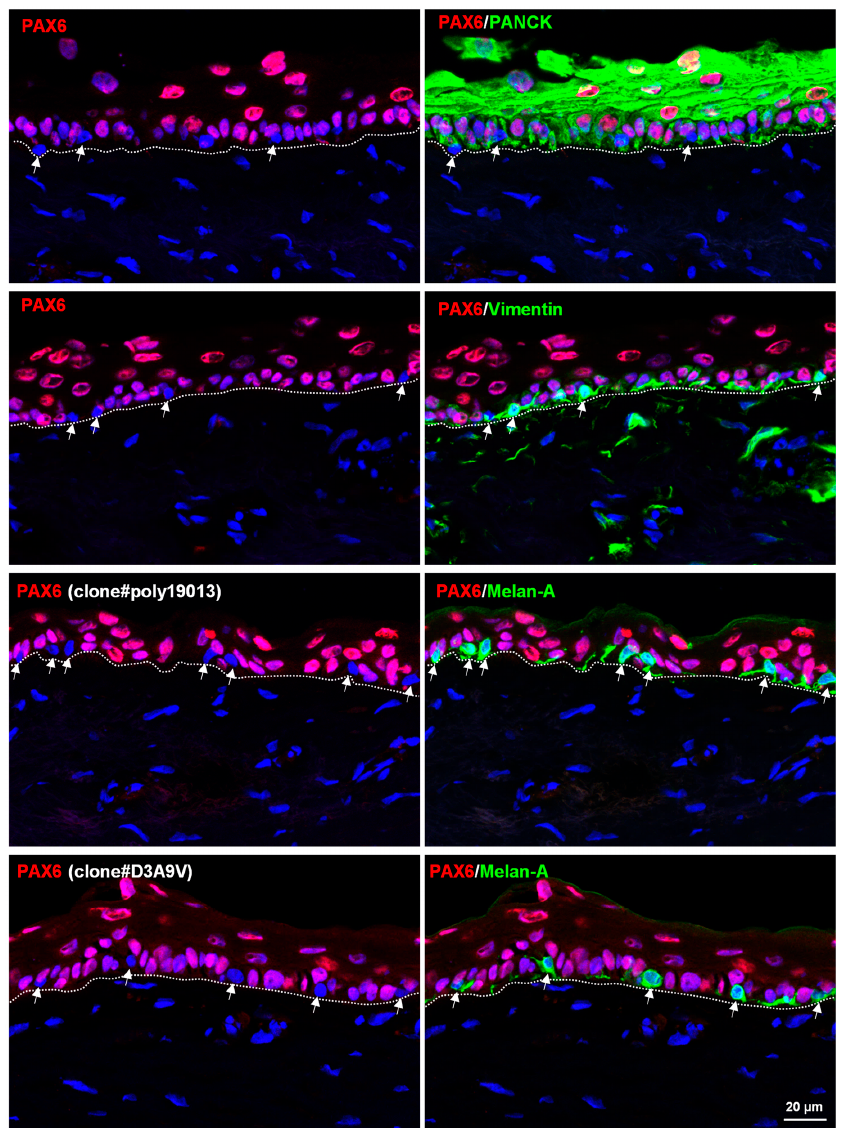
Figure 3. In situ localization of PAX6 in organ ‐ cultured human corneoscleral tissues ‐ Double immunostaining of organ ‐ cultured corneoscleral sections showing the expression of vimentin (arrow, green) but not the epithelial keratins (Pan ‐ CK, green) in PAX6 ‐ negative cells. PAX6 was not expressed by any of the cells in the limbal stroma (vimentin ‐ positive cells, green). Immunostained limbal sections also showing the expression of melanocyte marker Melan ‐ A (arrow, green) in the PAX6 ‐ negative cells at the basal layer of limbal epithelium. Nuclear counterstaining with 4 ′ ,6 ‐ diamidino ‐ 2 ‐ phenylindole (blue).